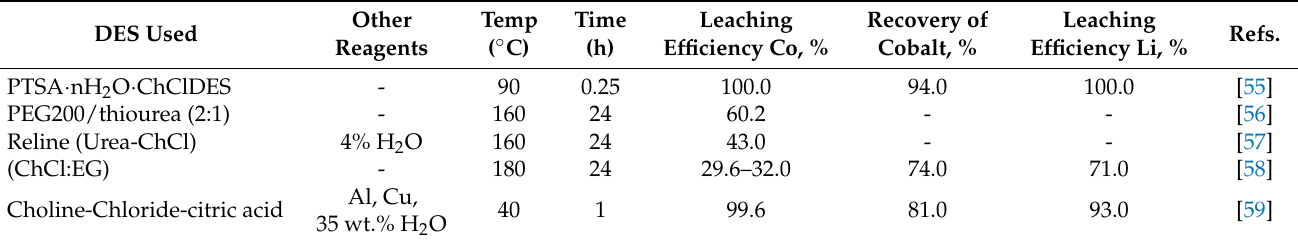
Table 3. Examples of Deep Eutectic Solvents (DES) used to leach cobalt from Li Battery